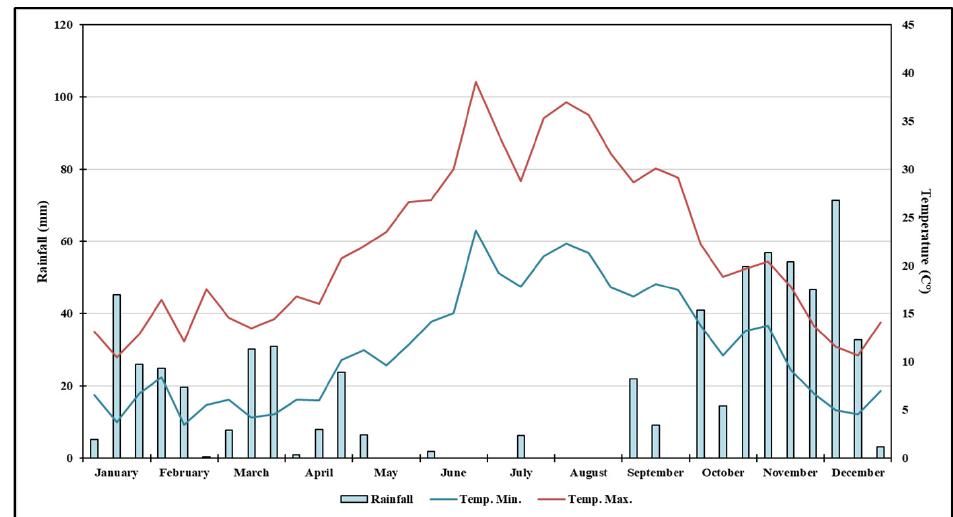
Figure 2. Rainfall and temperature trends in the year 2021.